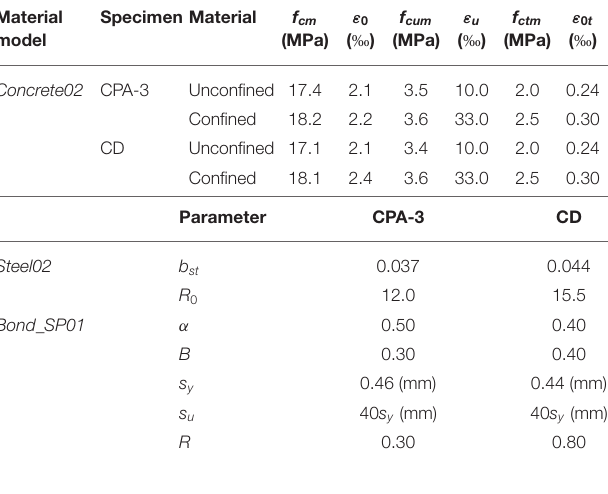
TABLE 2 | Values adopted for the Concrete02 , Steel02, and Bond_SP01 model parameters. Material